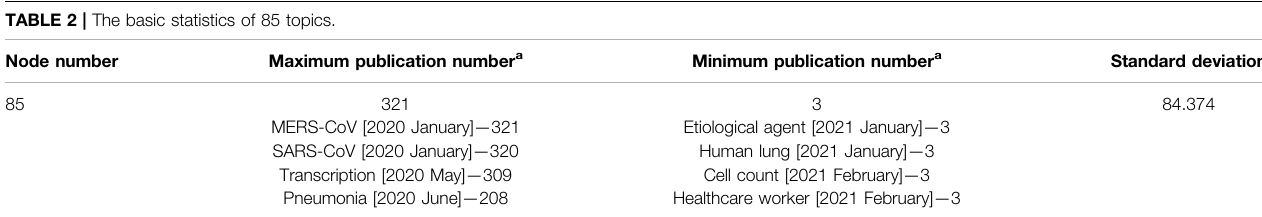
TABLE 2 | The basic statistics of 85